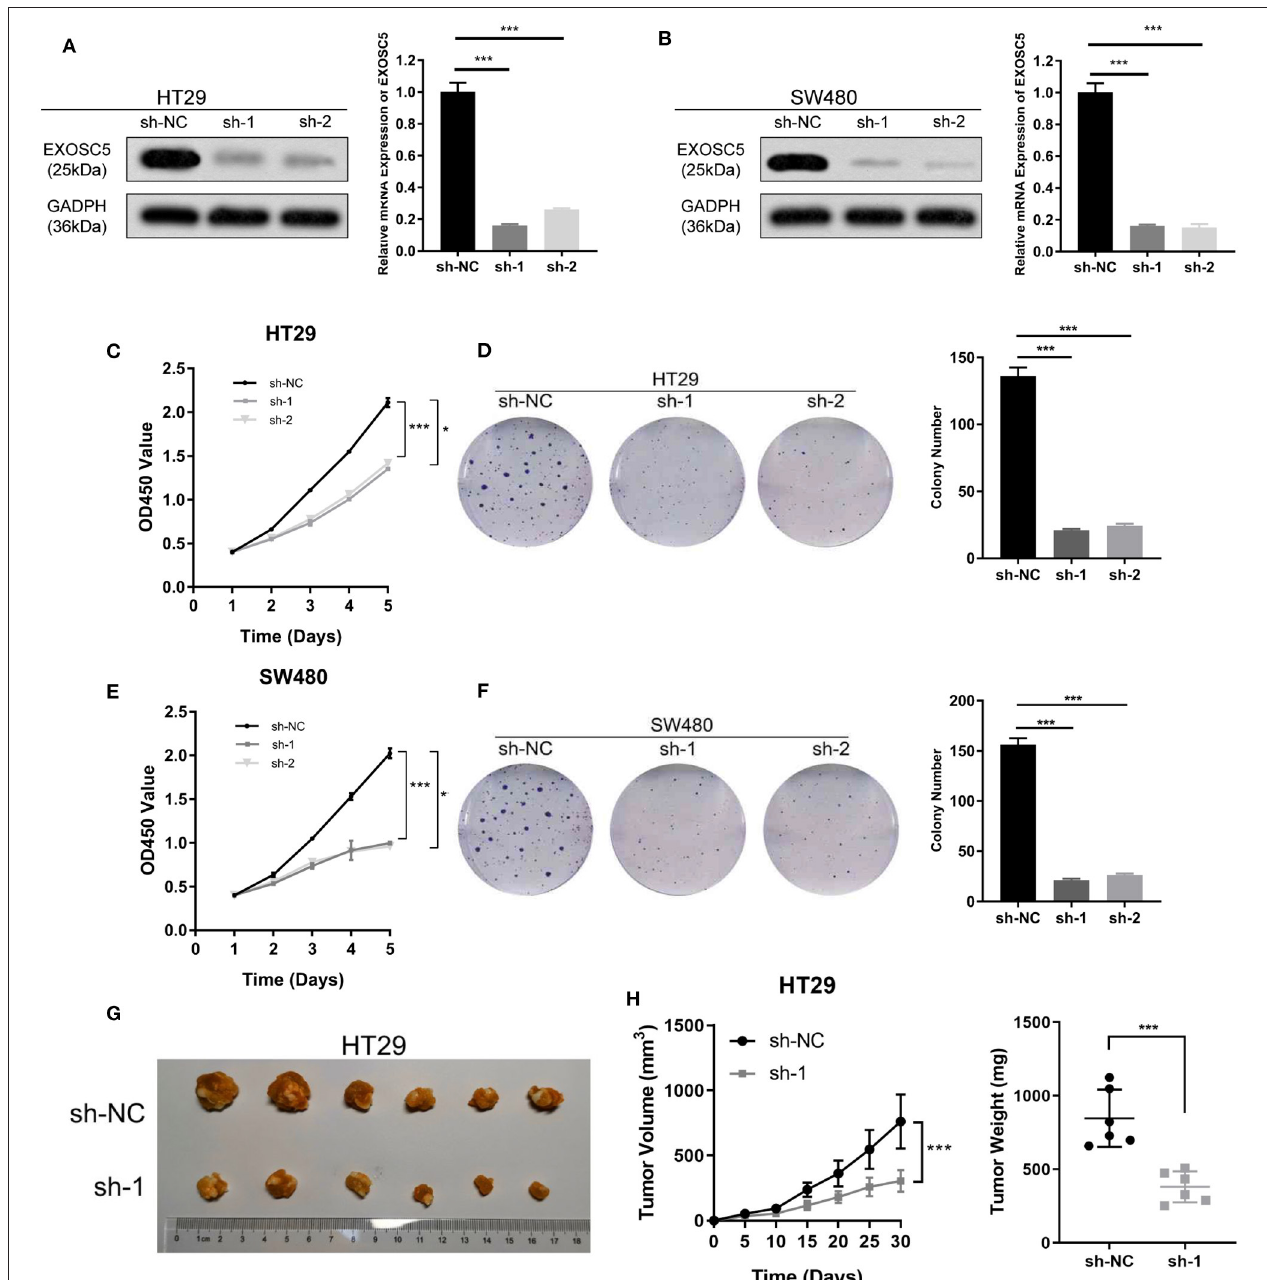
FIGURE 2 | Knockdown of EXOSC5 suppressed the proliferation and tumorigenesis of human CRC cells in vivo and in vitro . (A,B) The efficiency of EXOSC5 knockdown in HT29 and SW480 cells were determined by Western blot, GAPDH was used as a loading control. (C–F) Knockdown of EXOSC5 repressed cell proliferation by CCK-8 assays and colony formation assays. (G) Tumorigenesis assay by subcutaneous injection of HT29/sh-NC and HT29/sh-EXOSC5 cells in nude mice ( n = 6/group). (H) Tumor volumes were measured by growth curve every 5 days, and weights were measured on the terminal days. The results are presented as the mean ± SD. (* P < 0.05, *** P <